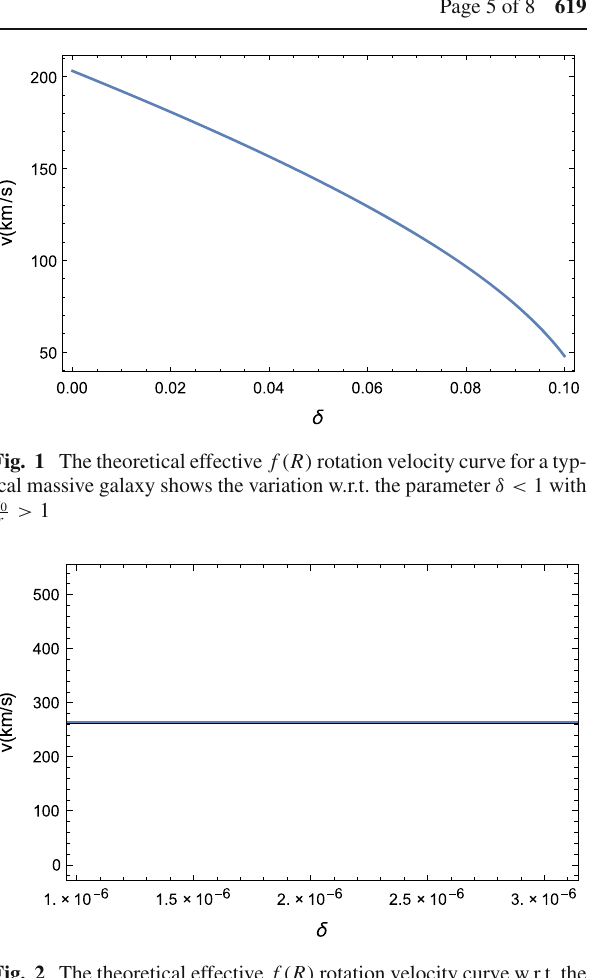
where the current value of H 0 (from the Planck data), H 0 = 67 . 4 ± 0 . 5 km s − 1 Mpc − 1 [12], the value of the